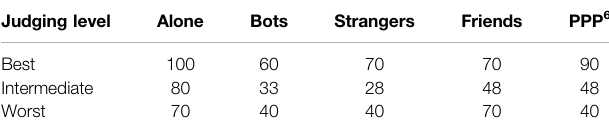
TABLE4| Distributionofthetypeofplayersusuallymetingamesaccordingtothe level of expertise (in percentage). Judging level